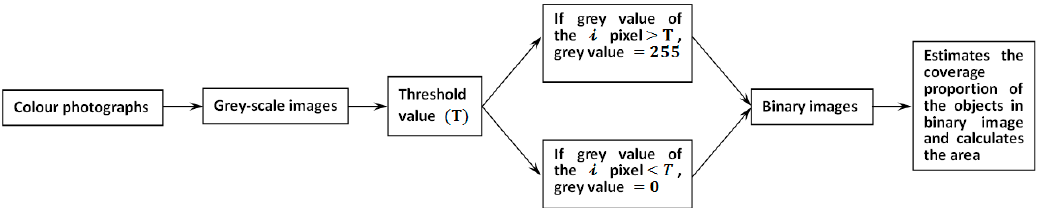
Figure 3. The flowchart for image processing.